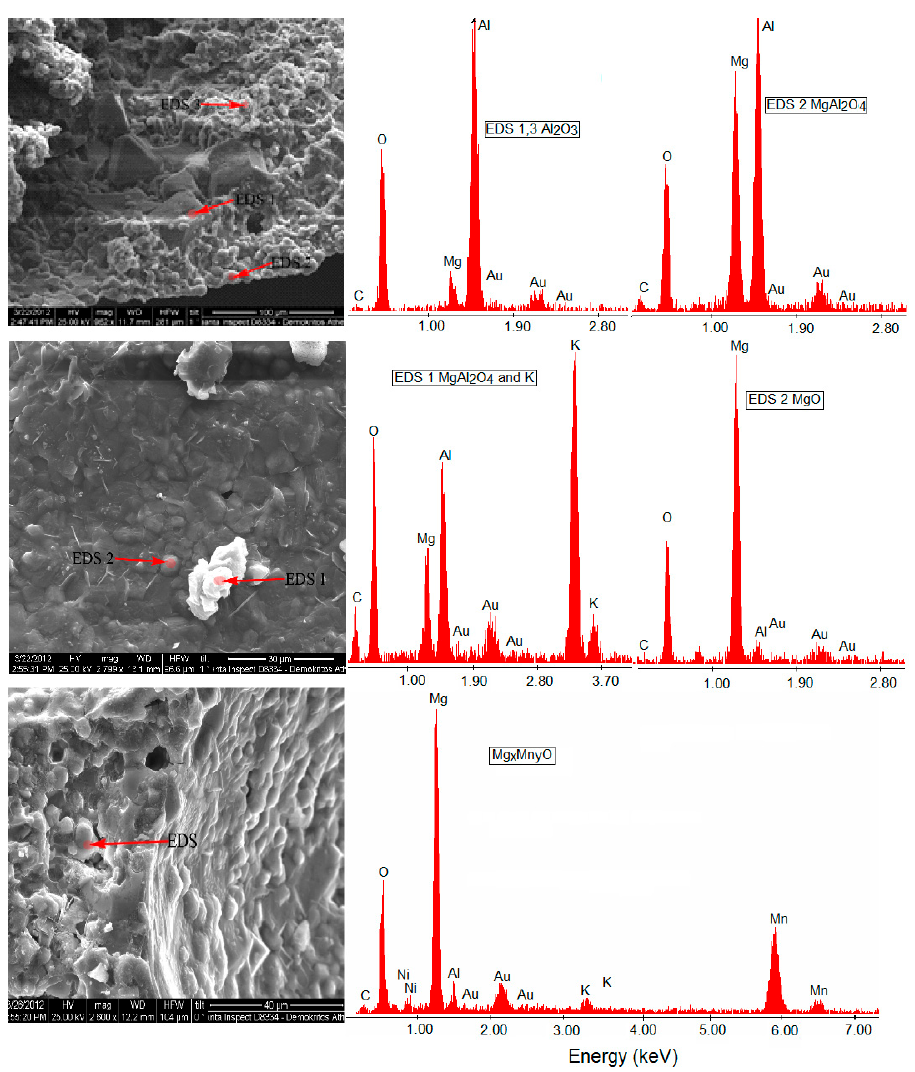
Figure 2. Initial batch: 13.04% MgO, 23.48% Al 2 O 3 , 30.44% Mg (NO 3 ) 2 , 13.04% KMnO 4 , 8% NiO, 4% Al, 8% Mg. Preheating temperature 600 °C.